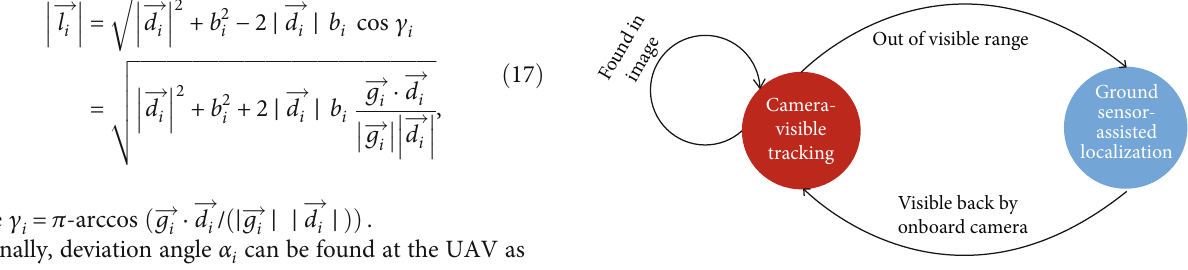
Figure 6: Sub-FSM of state tracking in Figure 3 — the object is continuously tracked by on-board cameras or ground sensor- assisted